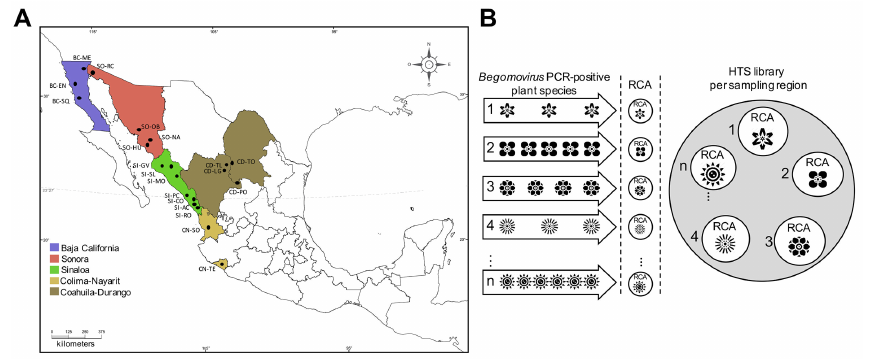
Figure 1. Northern-Pacific Mexico sampling areas and high-throughput sequencing (HTS) library construction. ( a ) Sampling areas were divided in five regions located in di ff erent biogeographic zones (according to the CONABIO classification): Baja California (BC), Sonora (SO), Sinaloa (SI), Colima-Nayarit (CN), and Coahulia-Durango (CD). BC-SQ: Baja California, San Quintin; BC-EN: